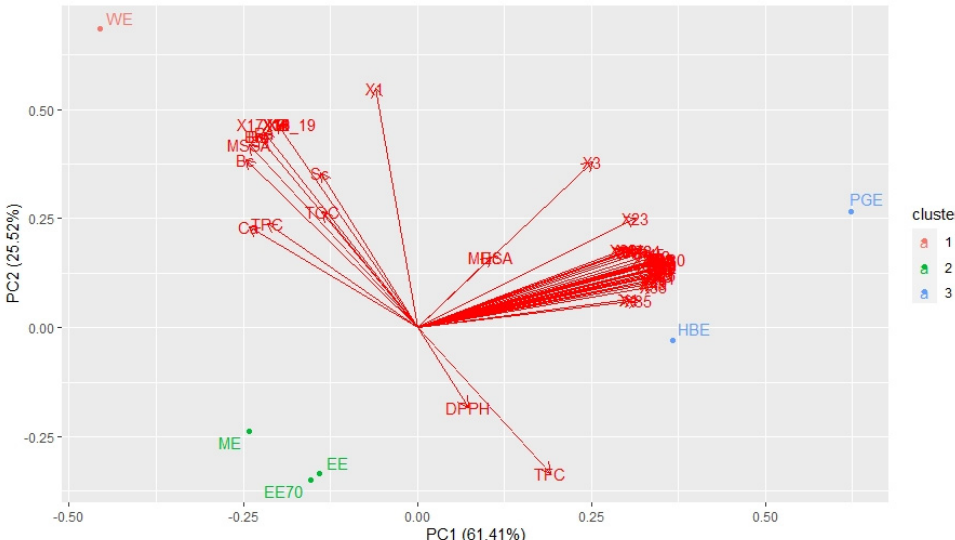
Figure 1. PC2 vs. PC1 biplot graph for the propolis samples and selected biochemical parameters.